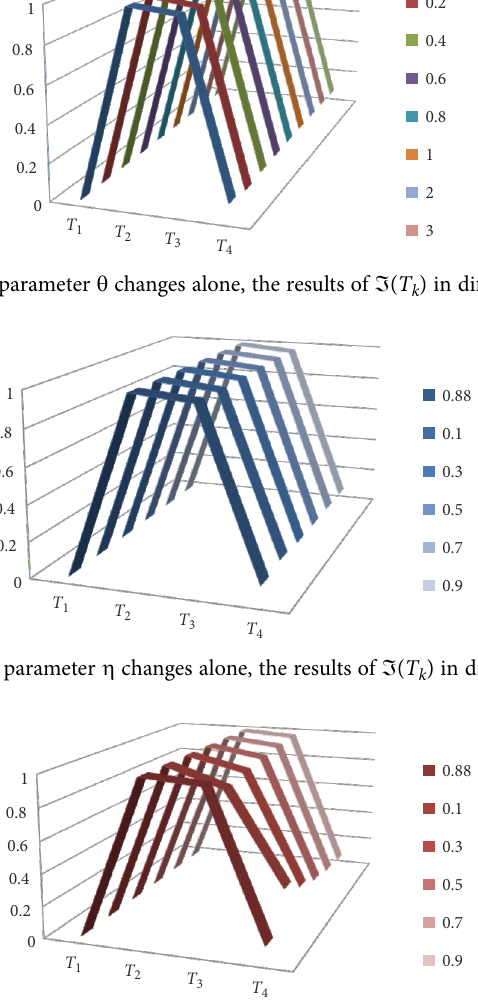
Figure 5. When parameter m changes alone, the results of ℑ ( T k ) in different